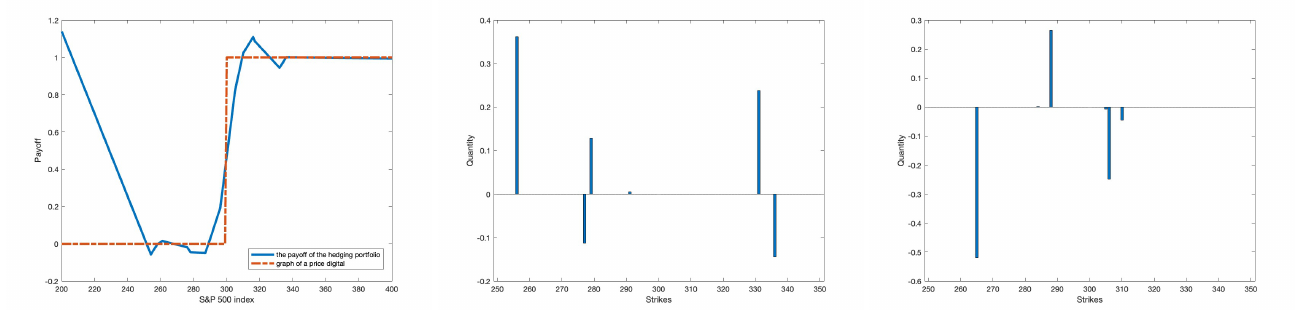
Figure 11. The payoff of the hedging portfolio together with the payoff of the claim being priced of a price digital ( left ), the hedging portfolios for the put option ( center ) and call option ( right ).